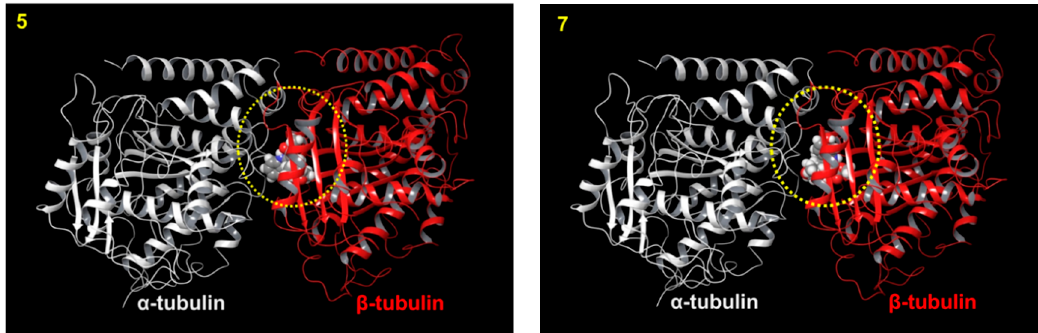
Figure 3. Predicted docking models for 5 and 7 binding to tubulin. Top 1 ranked docking models of 5 and 7 (sphere in 3D with gray in carbon, proton in white, oxygen in red, nitrogen in blue) in the colchicine site (CS, yellow circle) of the tubulin crystal structure ( α and β tubulin heterodimer: α - (white) and β -tubulin (red)) (PDB: 1SA0) are shown as a ribbon diagram.